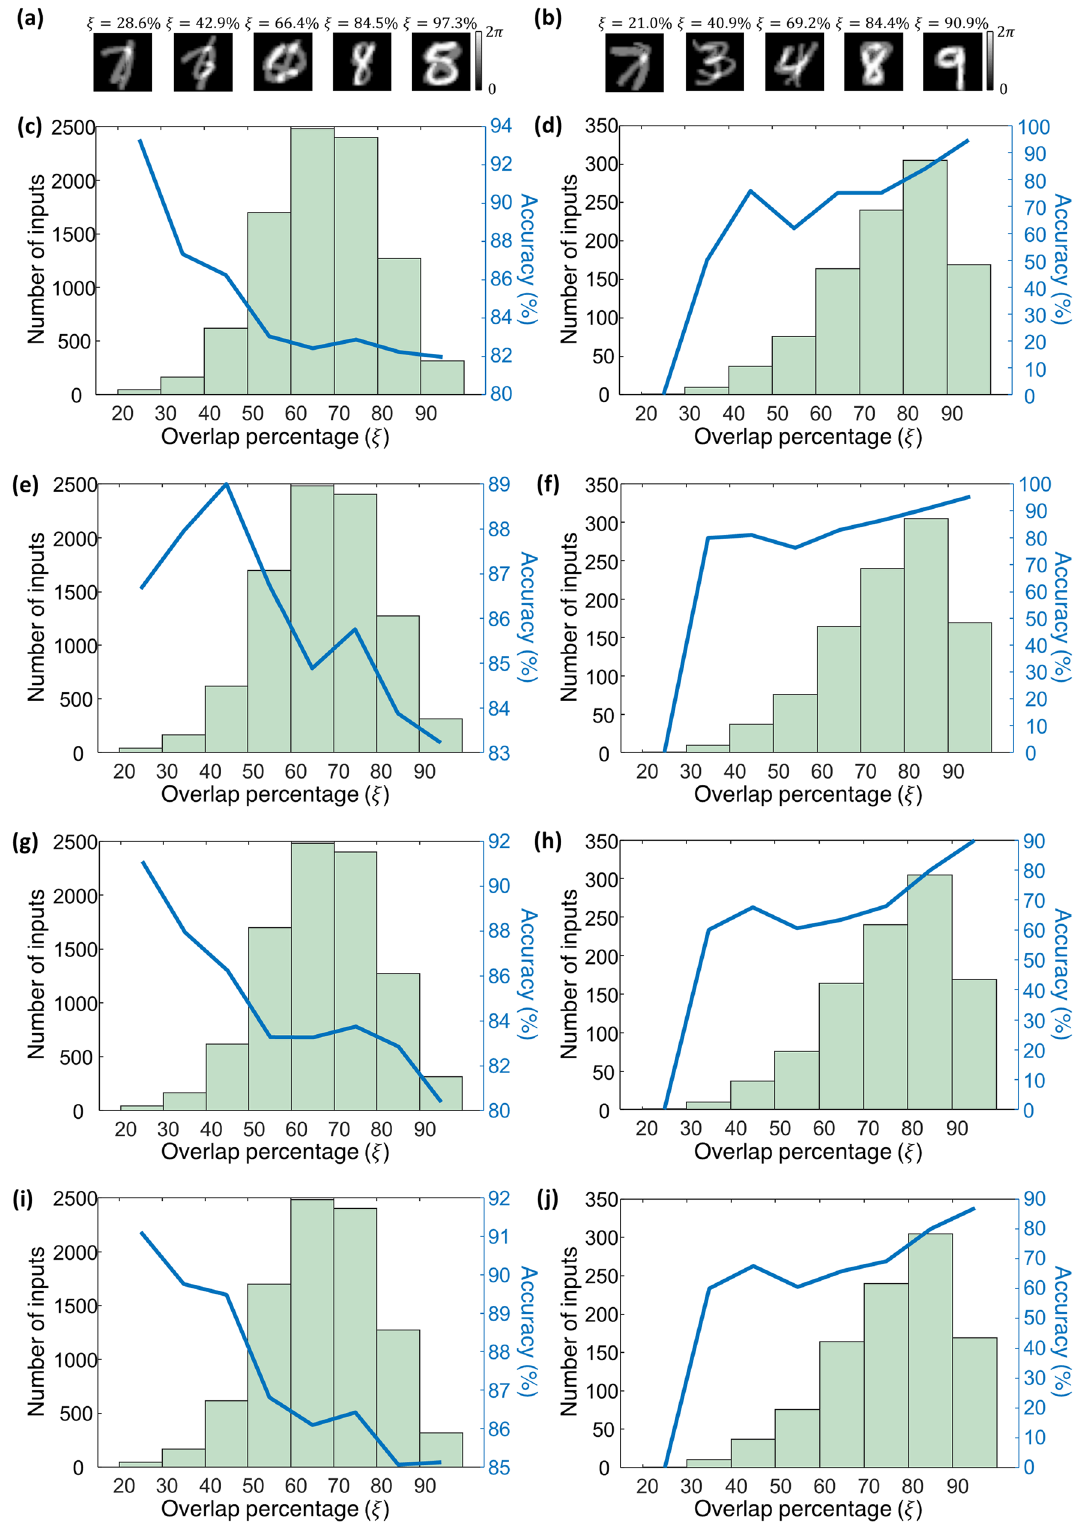
Figure 7. The variation in the optical blind inference accuracies of the presented diffractive optical networks as a function of the spatial overlap percentage (ξ) between the two input phase objects. ( a ) Sample input images from the test set T 2 containing overlapping phase objects from different data classes along with the corresponding overlap percentages, ξ . ( b ) Same as ( a ), except the overlapping objects are from the same data class. ( c ) The blind inference accuracy of the diffractive optical network, D 2 NN-D1, as a function of the overlap percentage, ξ , and the histogram of ξ , for test inputs in T 2 that contain phase objects from two different data classes. ( d ), Same as ( c ), except that the test inputs contain phase objects from the same data class. ( e , f ), Same as ( c , d ), except, the diffractive optical network design is D 2 NN-D1d. ( g , h ), Same as ( c , d ), except, the diffractive optical network design is D 2 NN-D2. ( i , j ), Same as ( c , d ), except, the diffractive optical network design is D 2